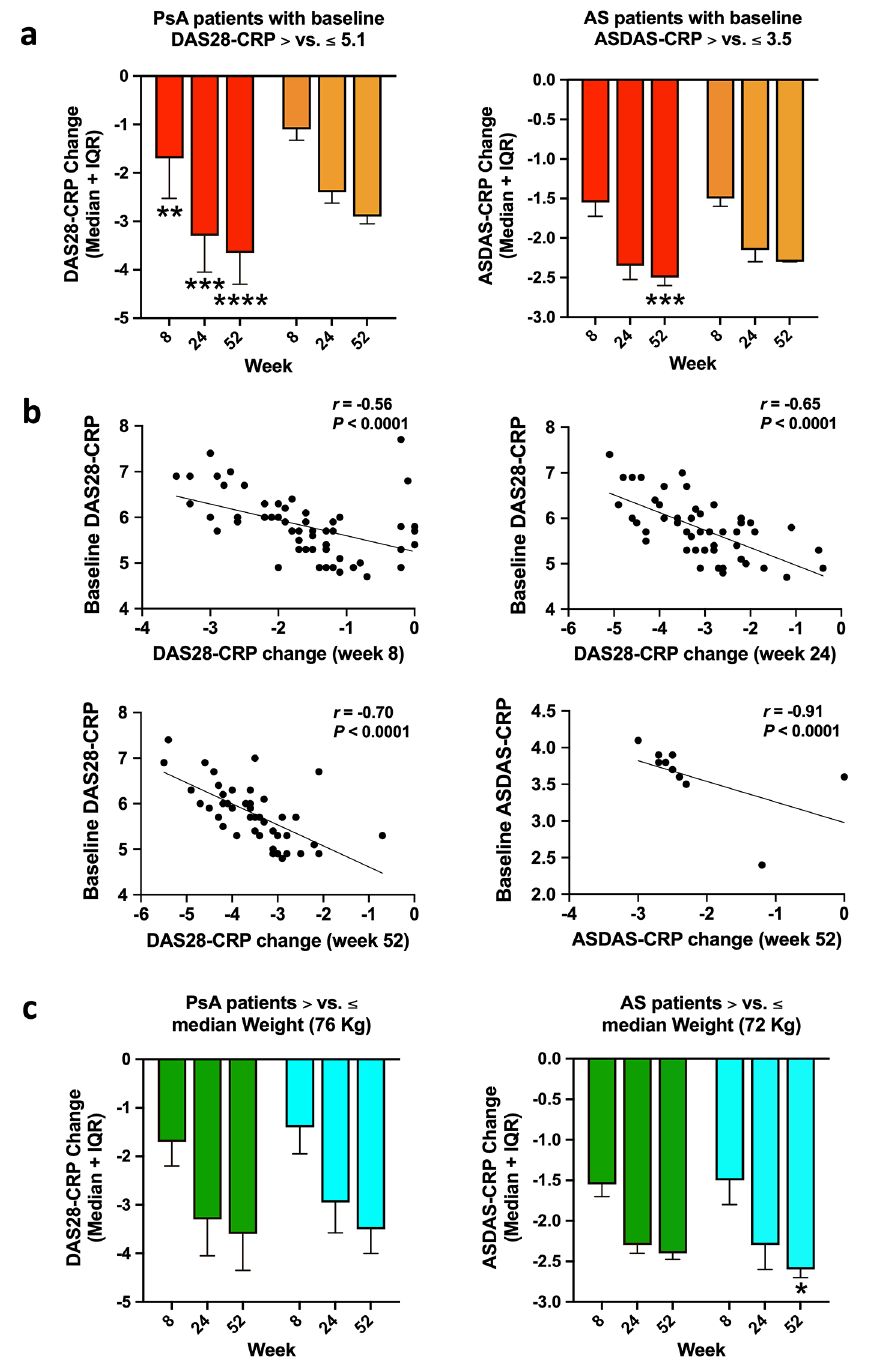
Fig. 2 Influence of baseline disease activity and body weight on response to secukinumab. a) Differences in median changes (+ interquartile range) of DAS28-CRP and ASDAS-CRP at 8, 24 and 52 weeks between patients with the highest vs. lower disease activity scores at baseline. ** P < 0.01, *** P < 0.001, **** P < 0.0001. b) Significant correlations between baseline disease activity and disease activity score changes at the various time points (Note: events in the fourth graph appear to be fewer than the number of patients analyzed due to overlapping dots). c) Differences in median changes (+ interquartile range) of DAS28-CRP and ASDAS-CRP at 8, 24 and 52 weeks between patients with body weights above and below median values. * P <